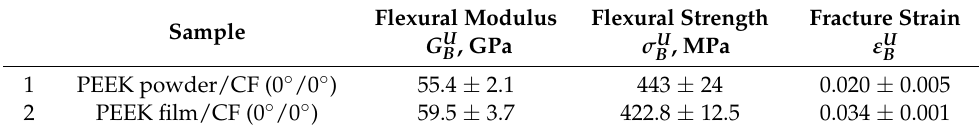
Table 2. The physical and mechanical properties of the CF reinforced